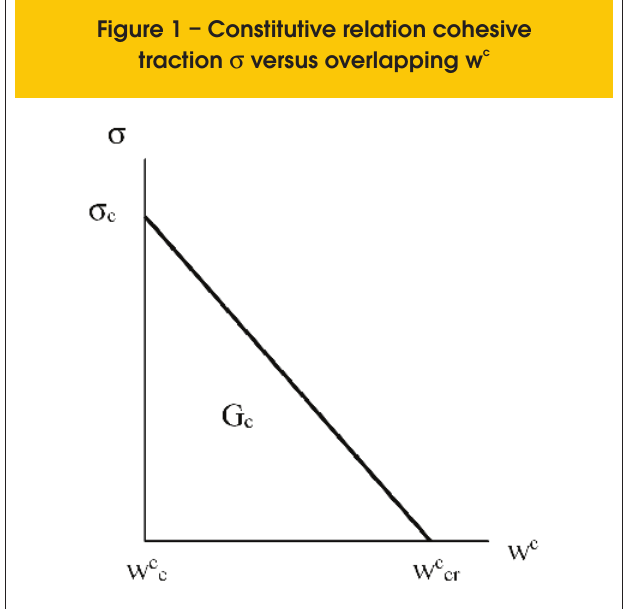
Figure 1 – Constitutive relation cohesive